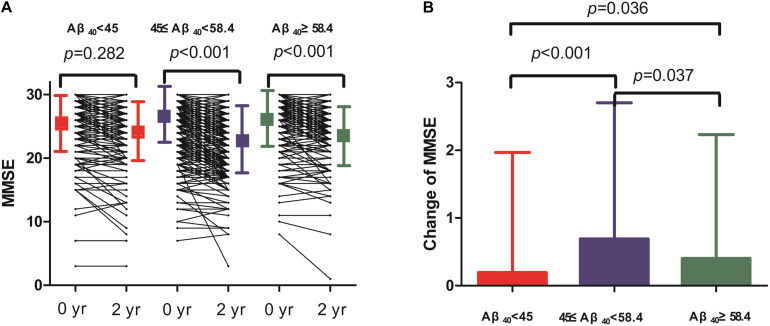
The changes of cognitive function during 2 year follow-up.